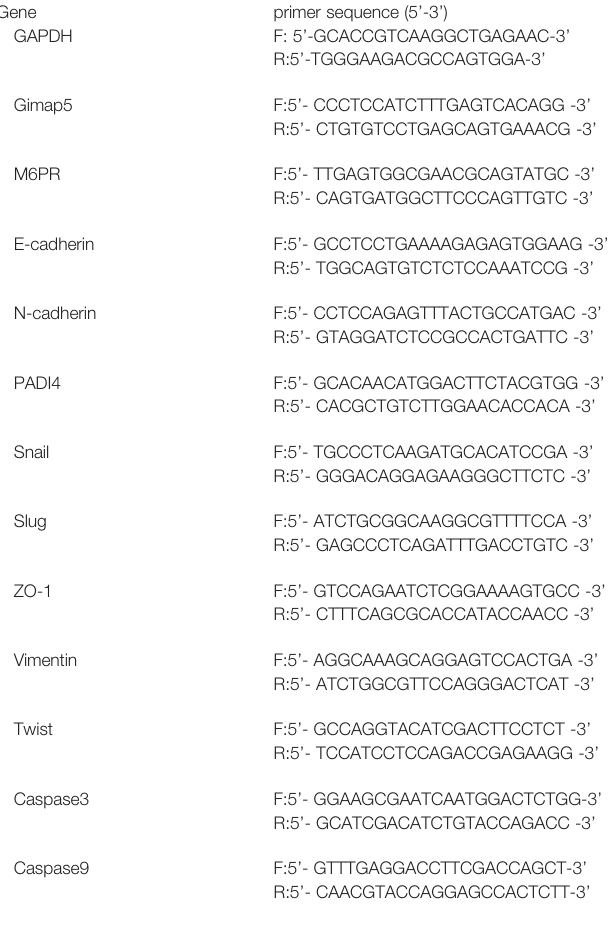
TABLE 1 | The primer sequences used in the